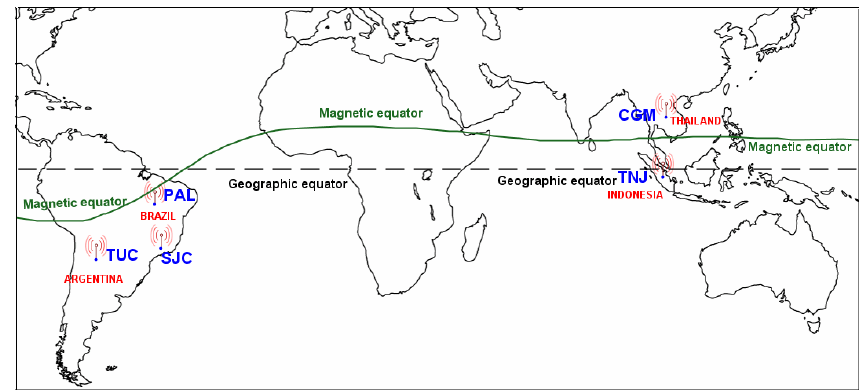
Fig. 1. Locations of the ionosondes used in the